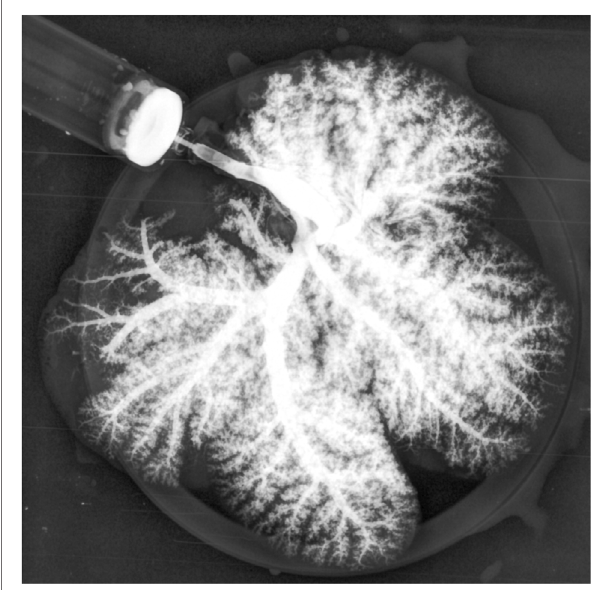
FIGURE 2 | Portal venogram of Decell-recell liver graft demonstrating patency of vasculature and no evidence of thrombosis after 1-h in vivo